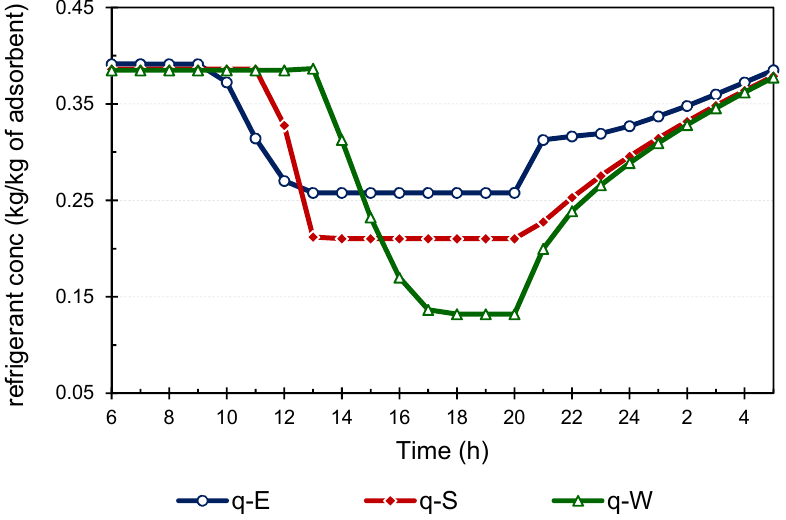
Figure 9. Concentration of refrigerant in each wing (28 August 2005, L = 0.5 m). and L cpc,S